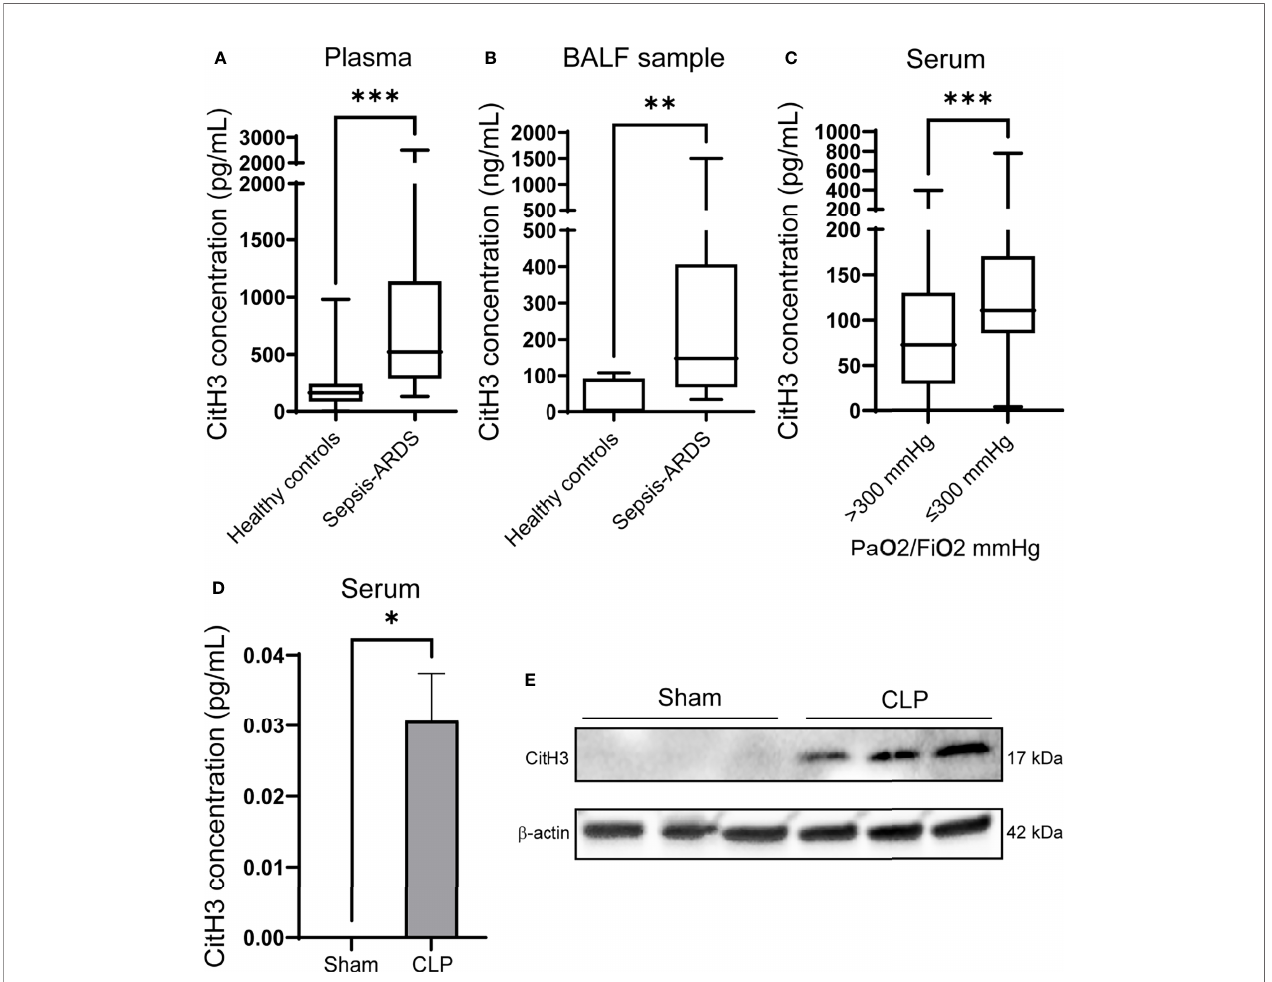
FIGURE 1 | CitH3 is increased in septic ARDS patients and CLP-induced animal model of sepsis. Levels of CitH3 in (A) plasma and (B) BALF from healthy controls and patients with sepsis-induced ARDS (n = 19 vs 13 for plasma samples; n = 7 vs 11 for BALF samples). (C) Circulating CitH3 in septic patients with PaO2/Fi02 > 300 mmHg (n=90) and ≤ 300 mmHg (n = 44). (D) Levels of serum CitH3 in sham and CLP-induced sepsis-ALI mouse model at 12 hours (n = 3/group). (E) Western blot results show the expression of CitH3 in mouse lung tissue with or without CLP (n = 3/group). Nonnormality data are expressed as minimal to maximal value with quantile range (A – C) . Data in D are expressed as mean ± SEM. *P < 0.05, **P < 0.01, ***P <0.001. SEM, standard error of the